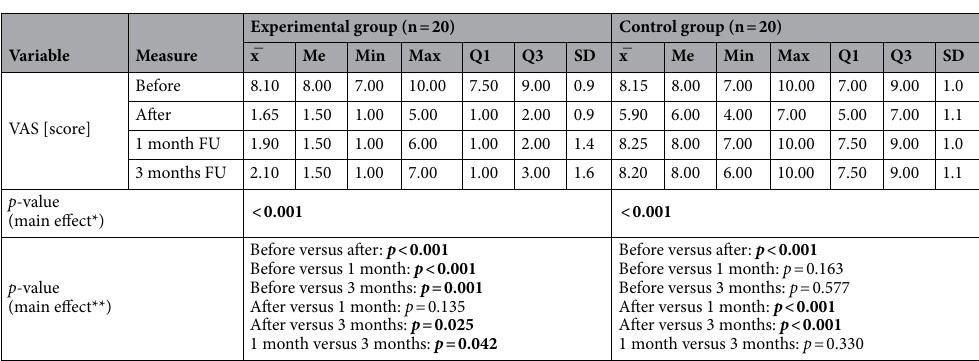
Table 2. The VAS scores in both groups (points). Significant values are in [bold]. n number of individuals, x ̅ , mean, Me median, Min minimum value, Max maximum value, Q1, lower quartile, Q3, upper quartile; SD standard deviation, FU follow-up. *Friedman’s ANOVA; **Dunn’s